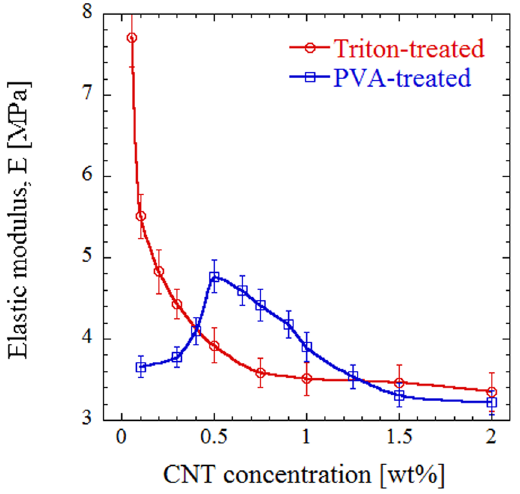
Figure 5. Compressive elastic modulus of porous samples as a function of CNT concentration for the two functionalization methods.